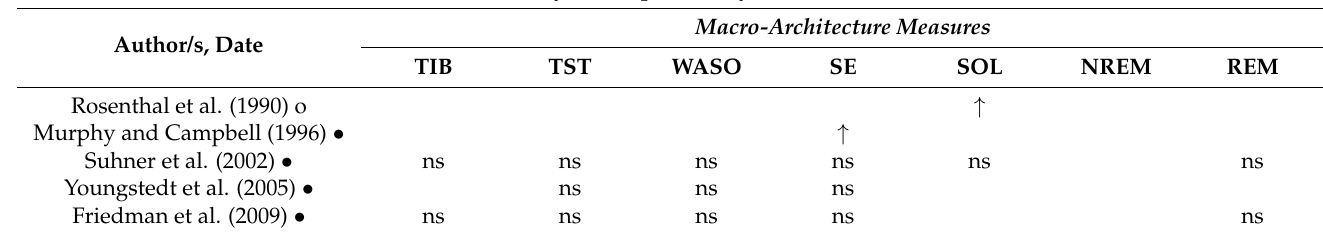
Table 2. Differences in macro-architecture of sleep EEG measures in light therapy conditions com- pared to control light